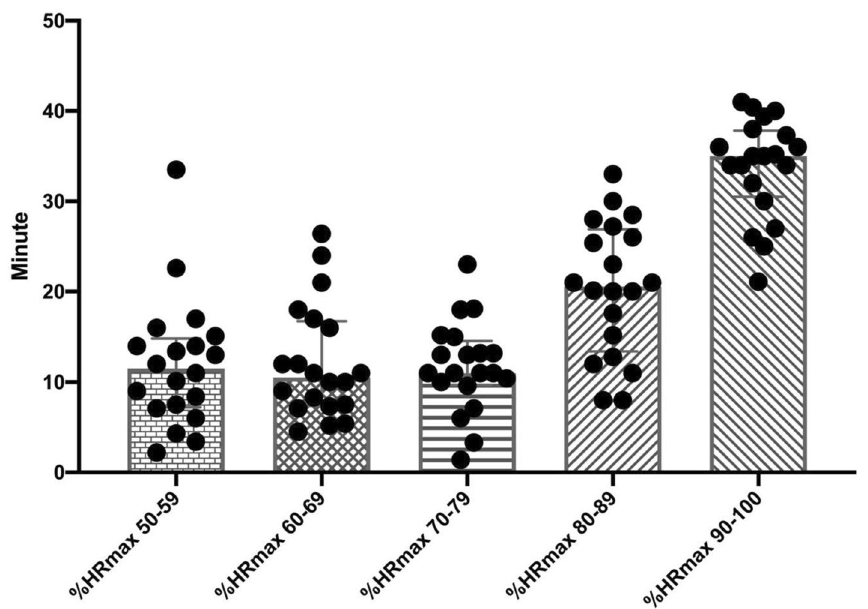
Figure 5. The time spent by all players during the match at% HRmax 50–59,% HRmax 60–69,% HRmax 70–79,% HRmax 80–89,% HRmax 90–100